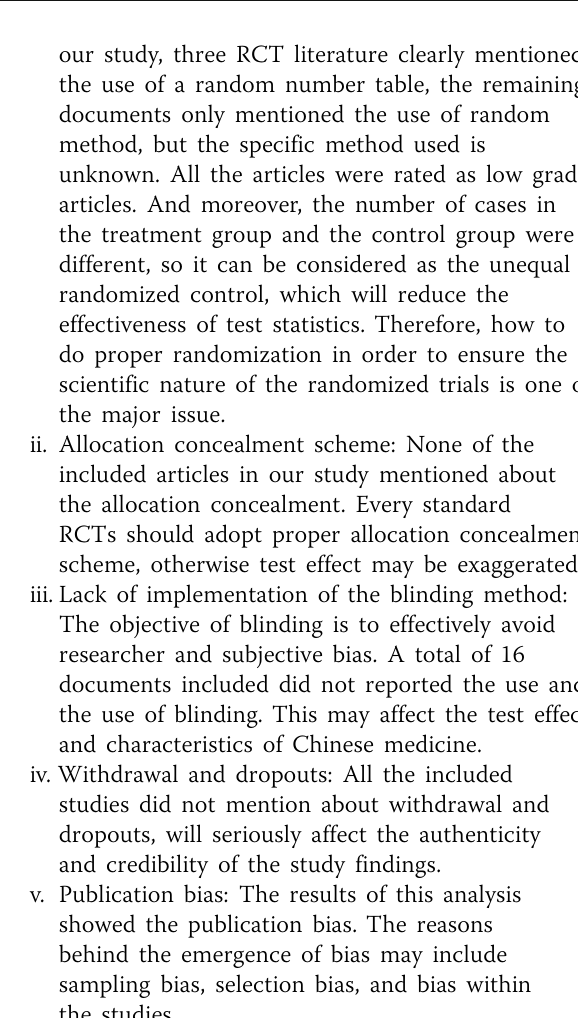
Fig. 6 Funnel plot of total efficacy rate of YCM on diabetic peripheral